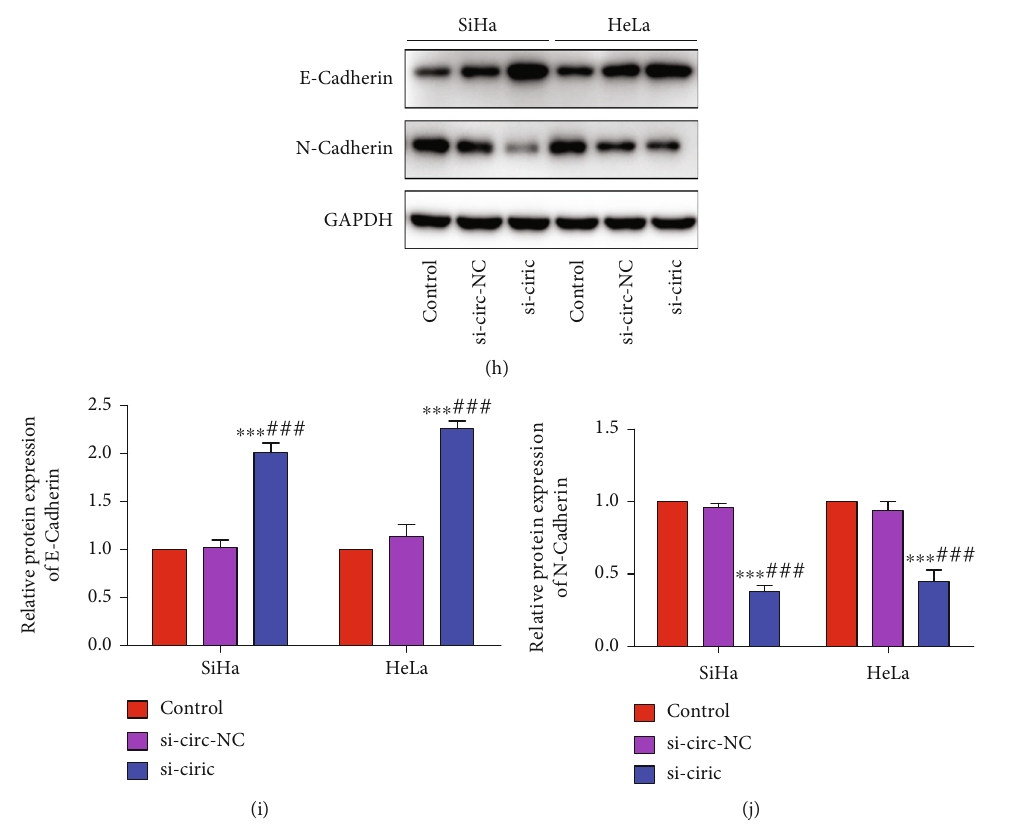
Figure 2: Inhibition of hsa_circ_0000511 signi fi cantly promoted the invasion and migration of SiHa and HeLa cells. The proliferation of SiHa (a) and HeLa (b) cells was increased when hsa_circ_0000511 was silenced; naturally, the expression of hsa_circ_0000511 was signi fi cantly decreased in the silenced cells (c). Moreover, when hsa_circ_0000511 was silenced, the invasion and migration abilities of SiHa (d) and HeLa (f) cells were also signi fi cantly enhanced; that is, the number of cells in lower Transwell chamber was signi fi cantly increased (e, g), respectively. In addition, the results of Western blot analysis (h) showed that the protein expression of E-cadherin was signi fi cantly increased (i) but that of N-cadherin was signi fi cantly decreased (j) in the hsa_circ_0000511 silenced group. Mean ± SD ; the data were analyzed by an unpaired two-sided t -test; vs. the control, ∗∗ p < 0 : 01 and ∗∗∗ p < 0 : 001 ; vs. si-circ-NC, ## p < 0 : 01 and ### p < 0 : 001